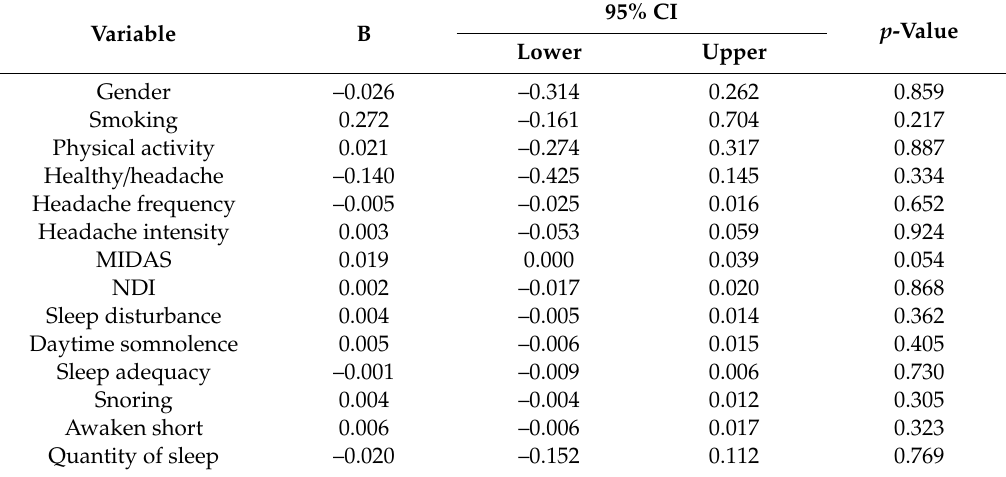
Table 3. Univariate linear regression to analyze the factors related to the degree of deviation of the perceived vertical from the theoretical